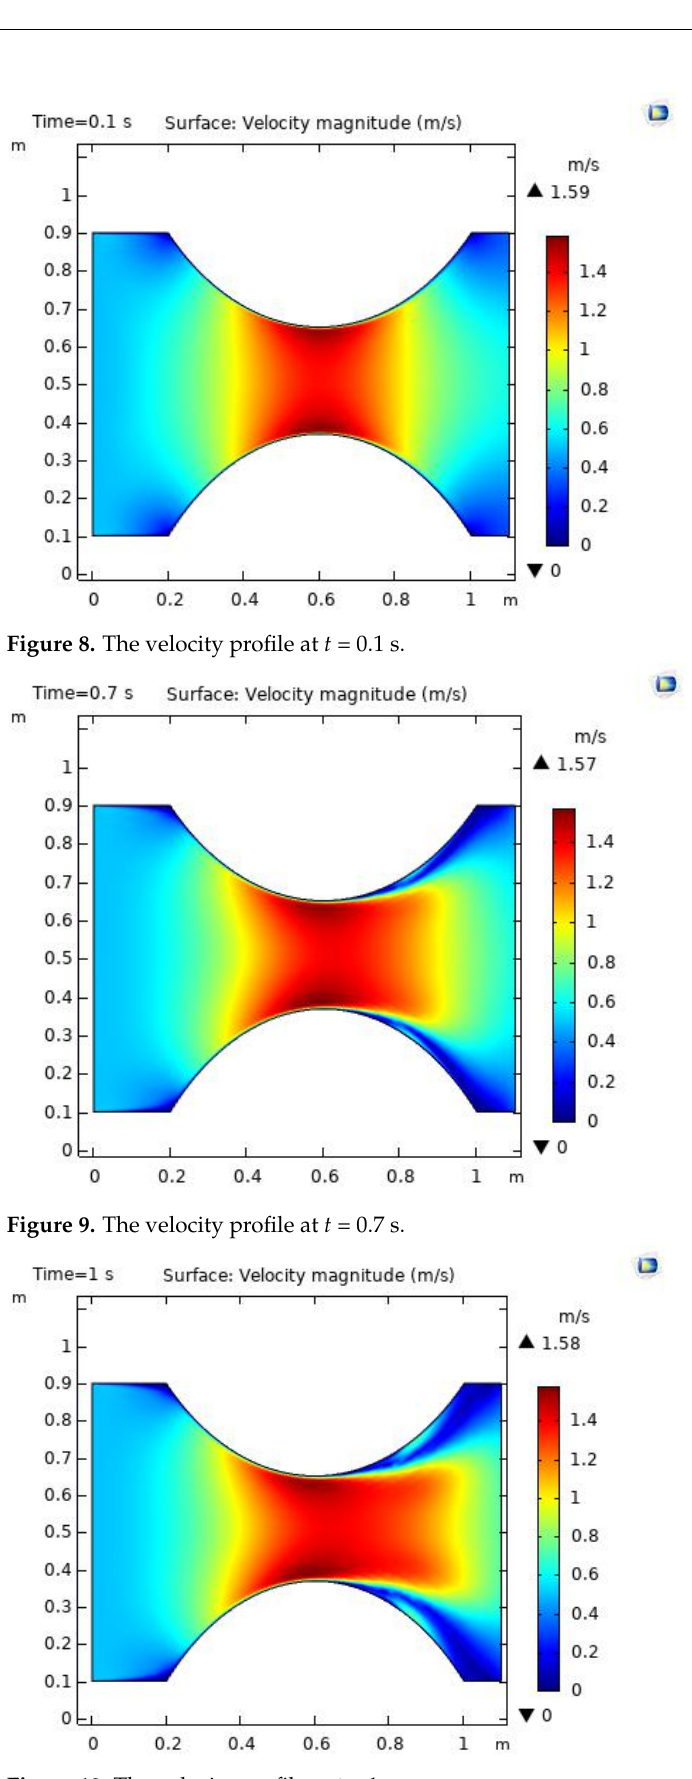
Figure 10. The velocity profile at t = 1 s.